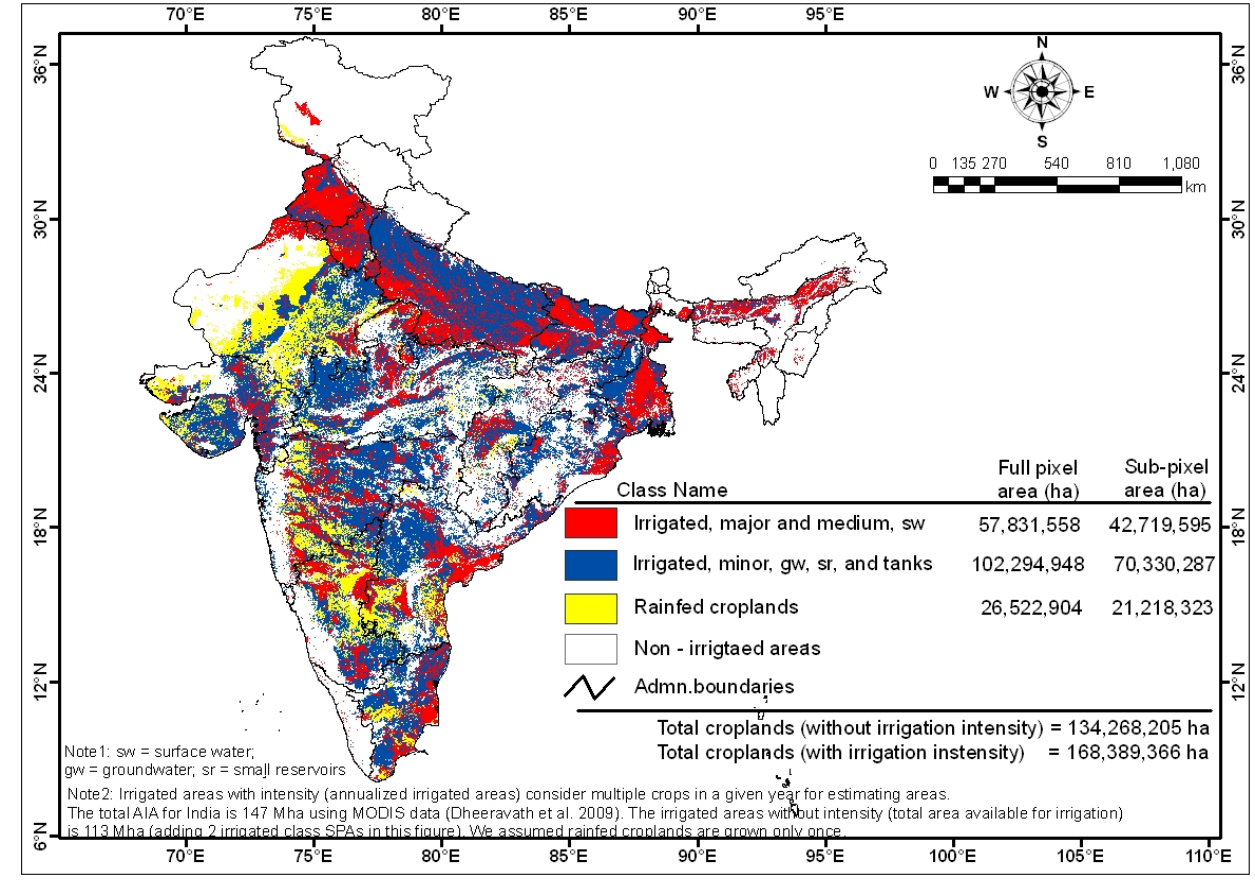
Figure 8. Cropland areas at higher spatial resolution of 500 m, which is adopted